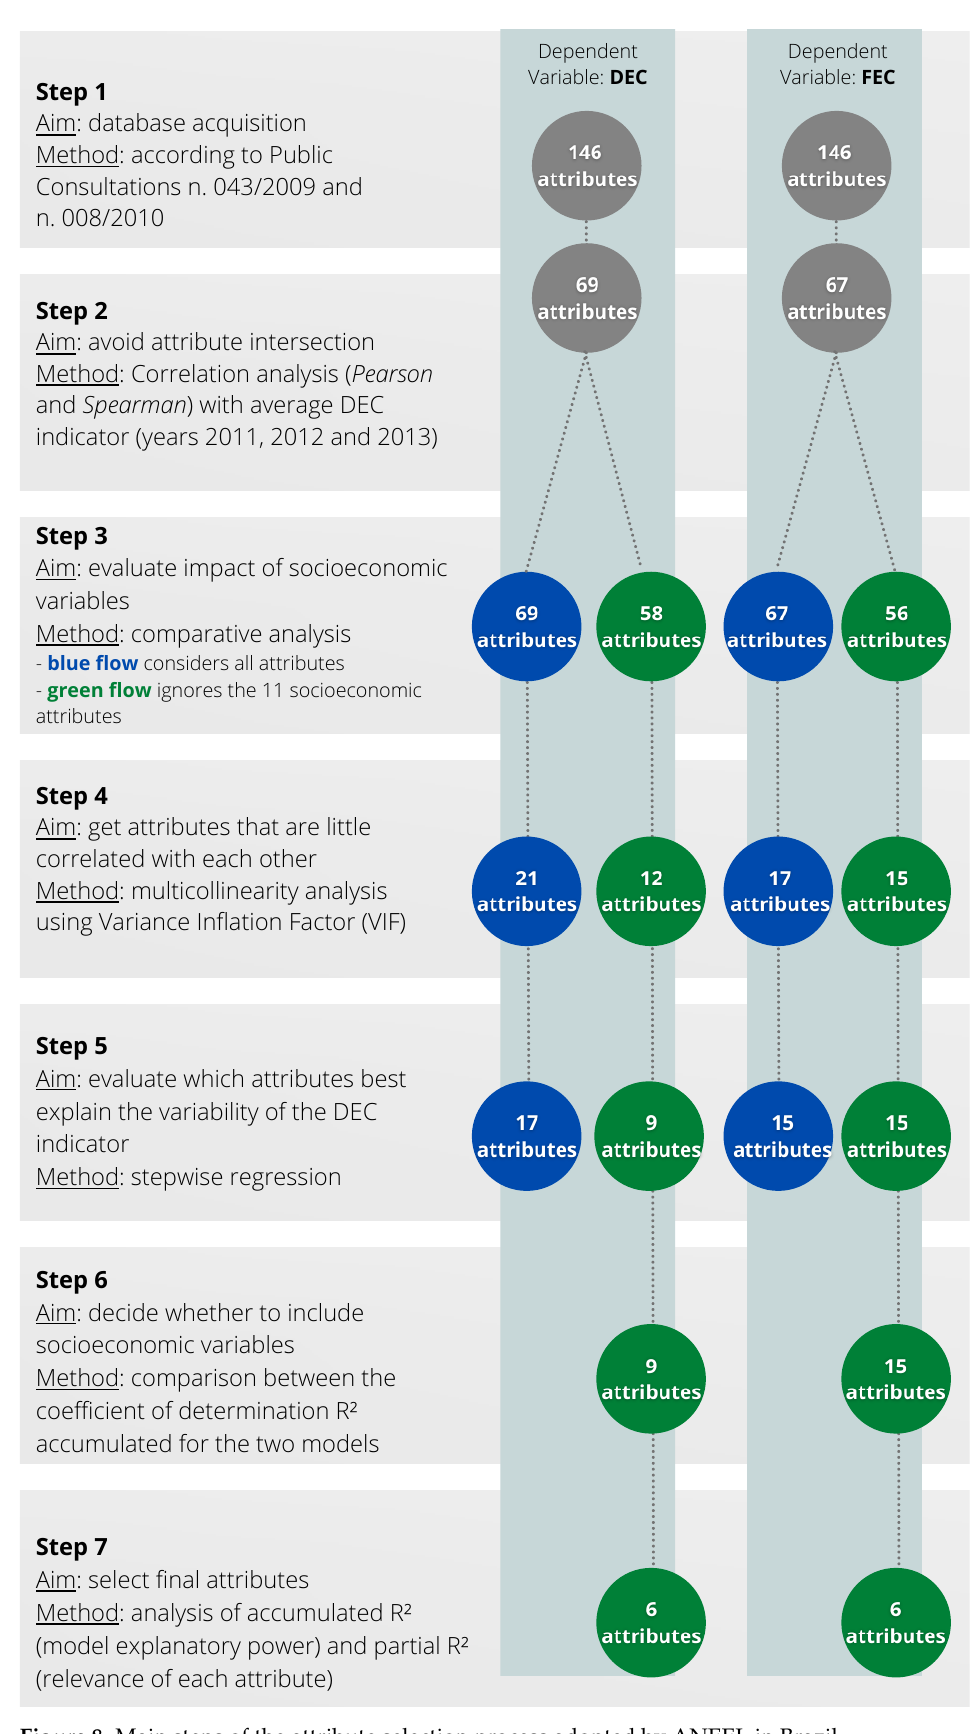
Figure 8. Main steps of the attribute selection process adopted by ANEEL in